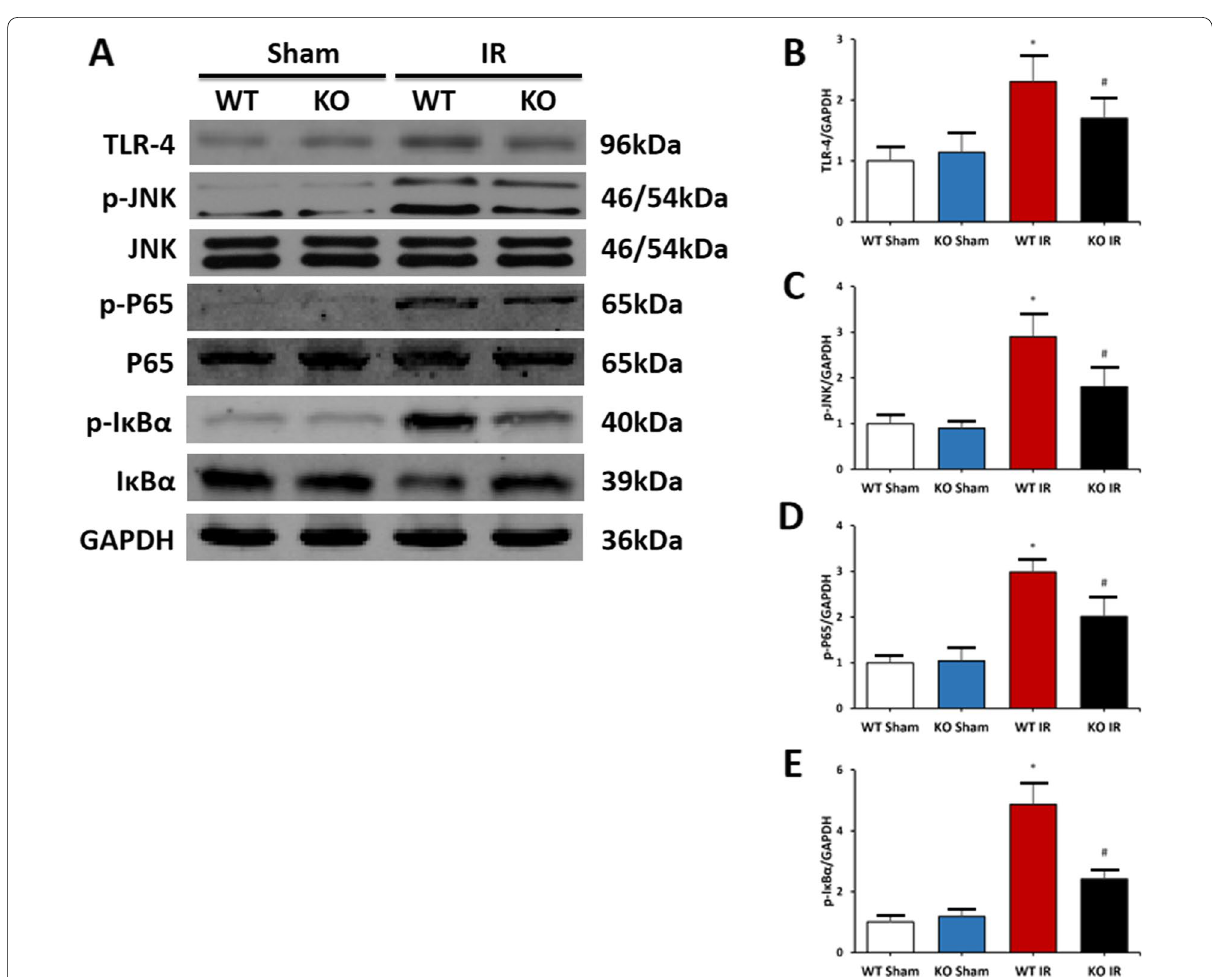
Fig. 4 Mindin deficiency inhibited TLR4/JNK/NF-κB signaling activation in renal IR injury A TLR4, phosphorylated JNK, phosphorylated P65, and phosphorylated IκBα measured by western blot analysis in kidneys of WT and mindin KO mice induced by IR or not. B – E Quantitative analysis of TLR4, phosphorylated JNK, phosphorylated P65, and phosphorylated IκBα protein expression. *P < 0.05 versus WT Sham or KO Sham. # P < 0.05 versus WT IR